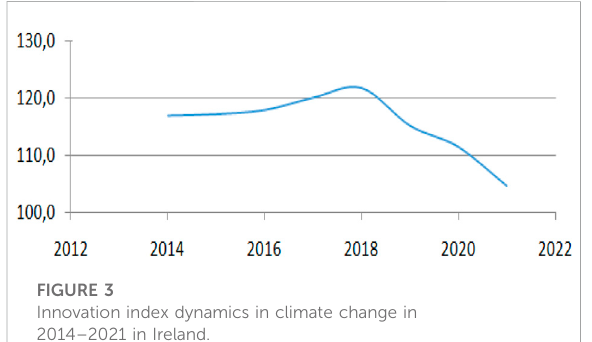
FIGURE 3 Innovation index dynamics in climate change in 2014 – 2021 in Ireland.